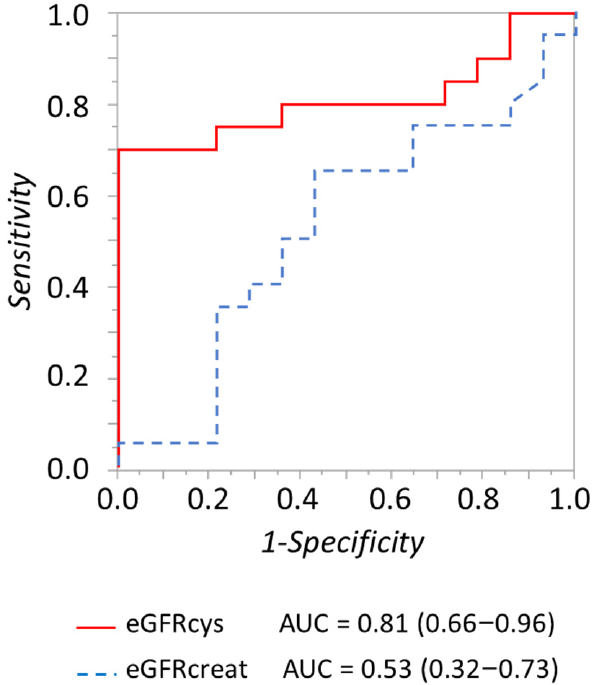
Figure 2. ROC curves of the relationship between eGFRcys (solid line) or eGFRcreat (dashed line) and recovery from severe eGFRcreat depression defined as eGFRcreat < 30 mL/min/1.73 m 2 in patients with obstructive nephropathy ( n = 34). The baseline eGFRcys was associated with recovery from severe eGFRcreat depression, whereas the baseline eGFRcreat was not. Abbreviations: eGFR, estimated glomerular filtration rate; eGFRcys, eGFR calculated with serum cystatin C; eGFRcreat, eGFR calculated with serum creatinine; AUC, area under the curve. (14/20) and specificity of 100%